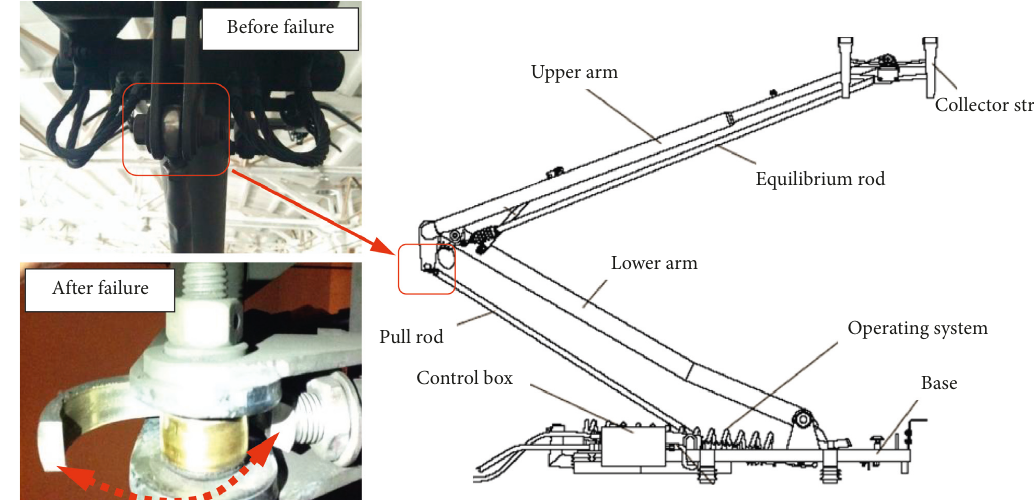
Figure 7: Damaged outer rings of the joint bearing of the pull rod.